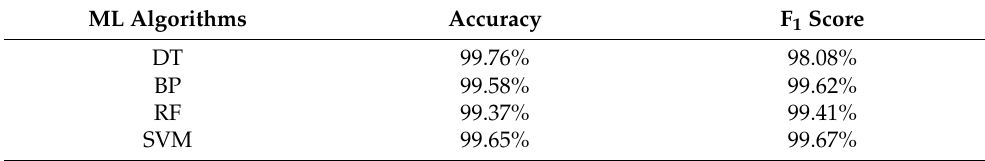
Table 3. Recognition performance comparison of the state-of-art machine learning algorithms.